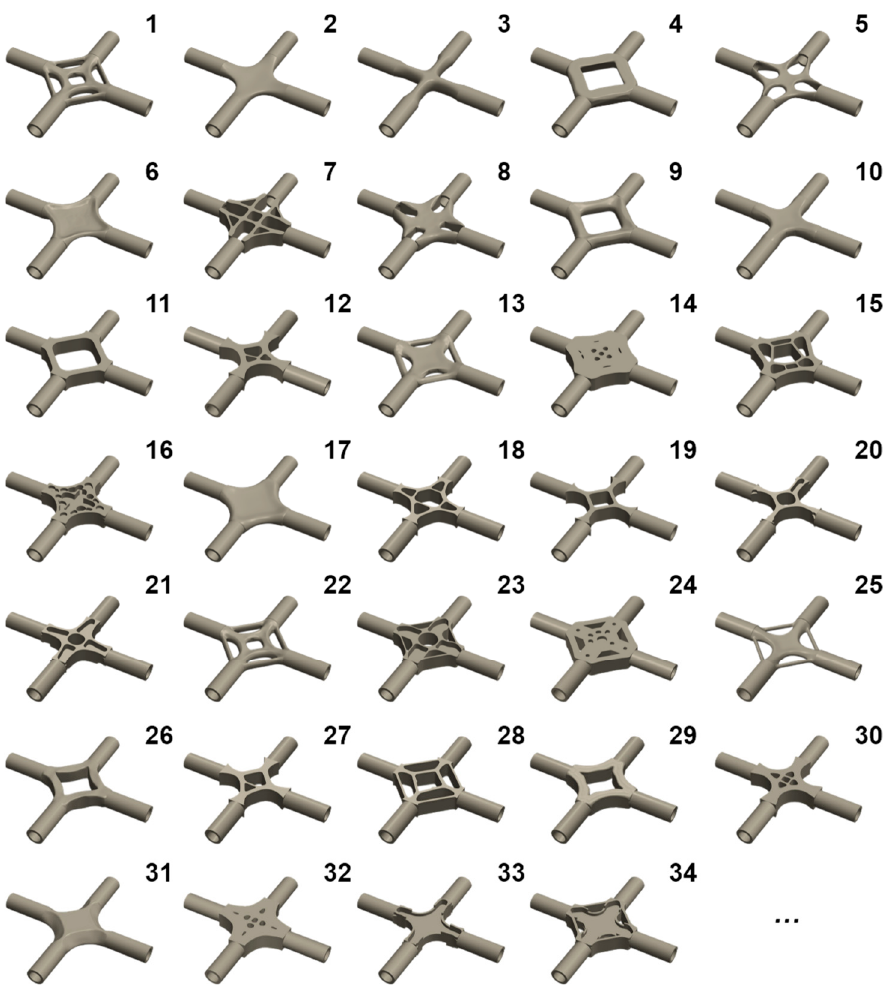
Figure 4. Partial generative design results of the cross joint.